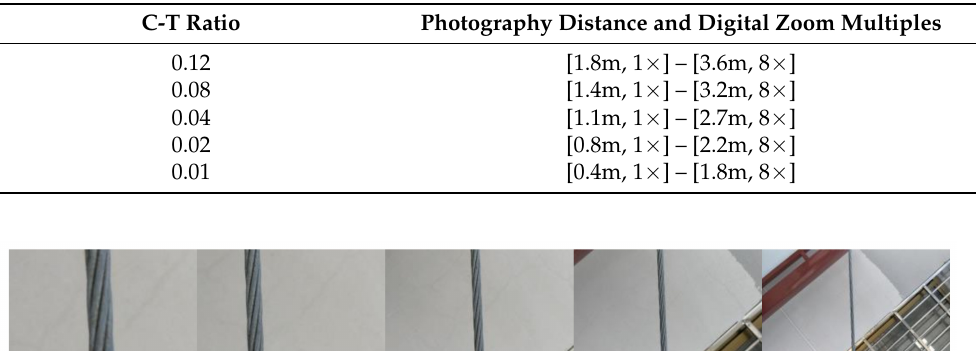
Figure 2. Screenshots of continuous videos with different cable pixel-to-total pixel (C-T) ratios (left to right, 0.12, 0.08, 0.04, 0.02, and 0.01,